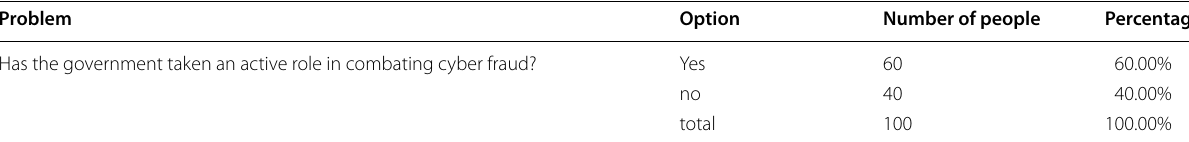
Table 5 Whether the government has taken an active role in governance and combating cyber fraud